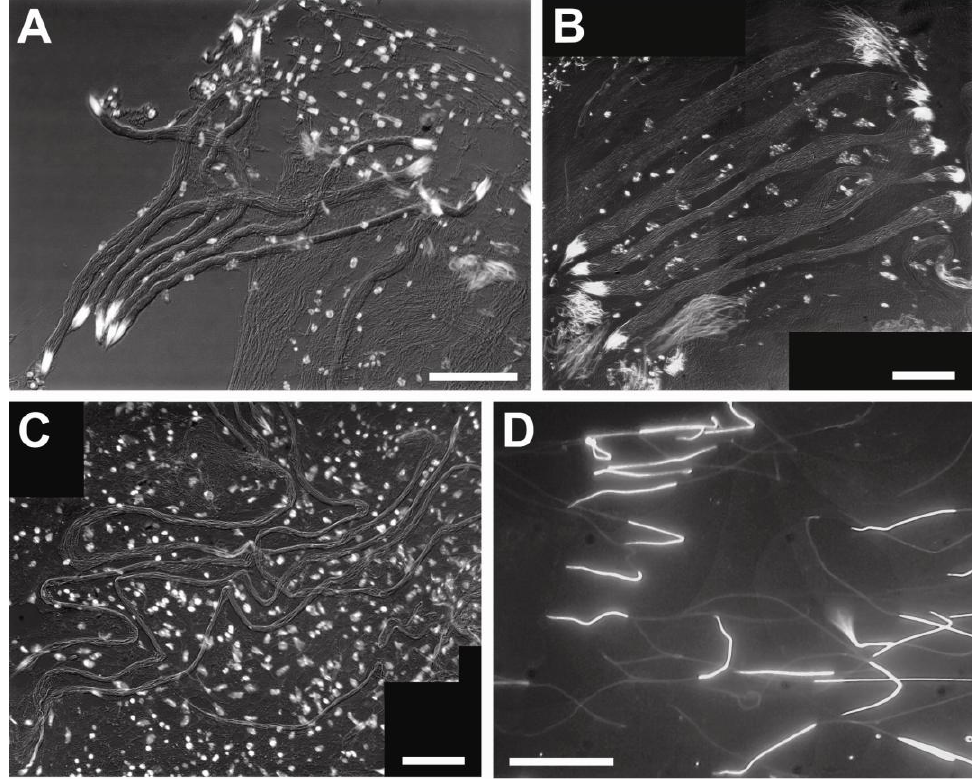
Figure 2. Representative whole mounts of sperm are shown. Sperm were measured